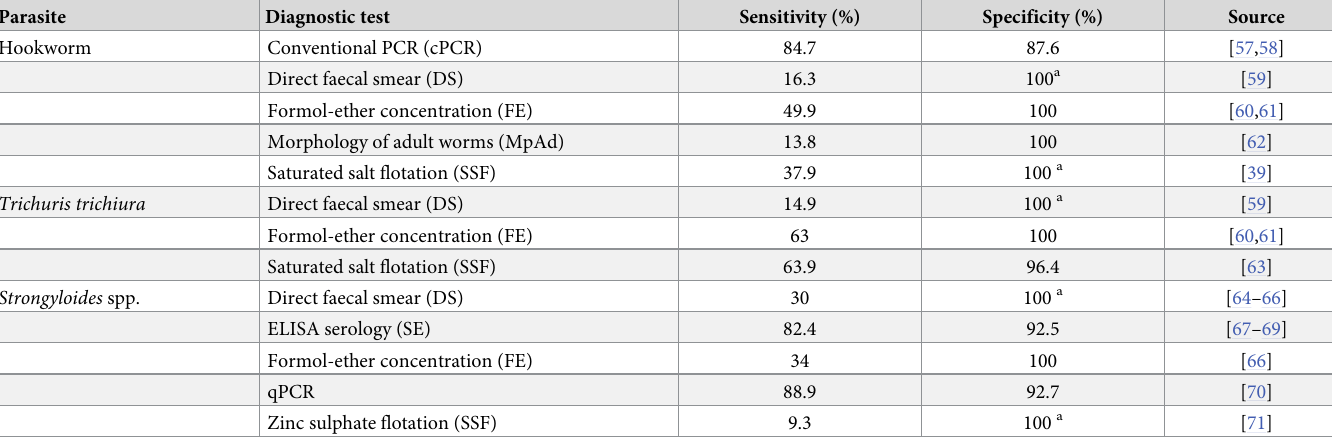
Table 2. Sensitivity and specificity data for tests used in studies included for meta-analysis.